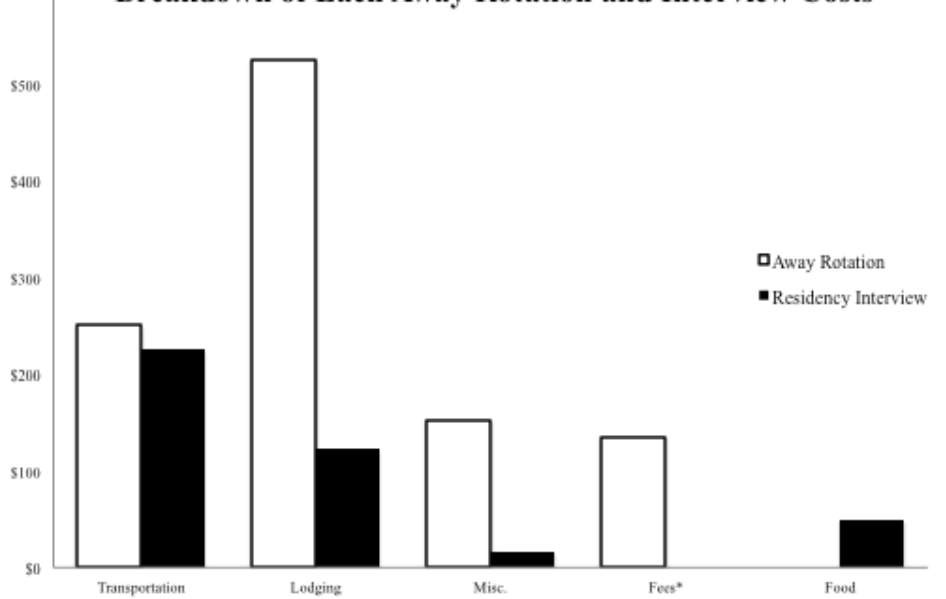
Figure. Breakdown of each away rotation and residency interview costs: Applicants were asked to breakdown the total costs of completing away rotations and attending residency interviews into individual components. *Away rotations often charge fees that can include VSAS application fees, additional individual school fees, vaccination or titer requirements, drug screens, and malpractice insurance. VSAS, visiting student application